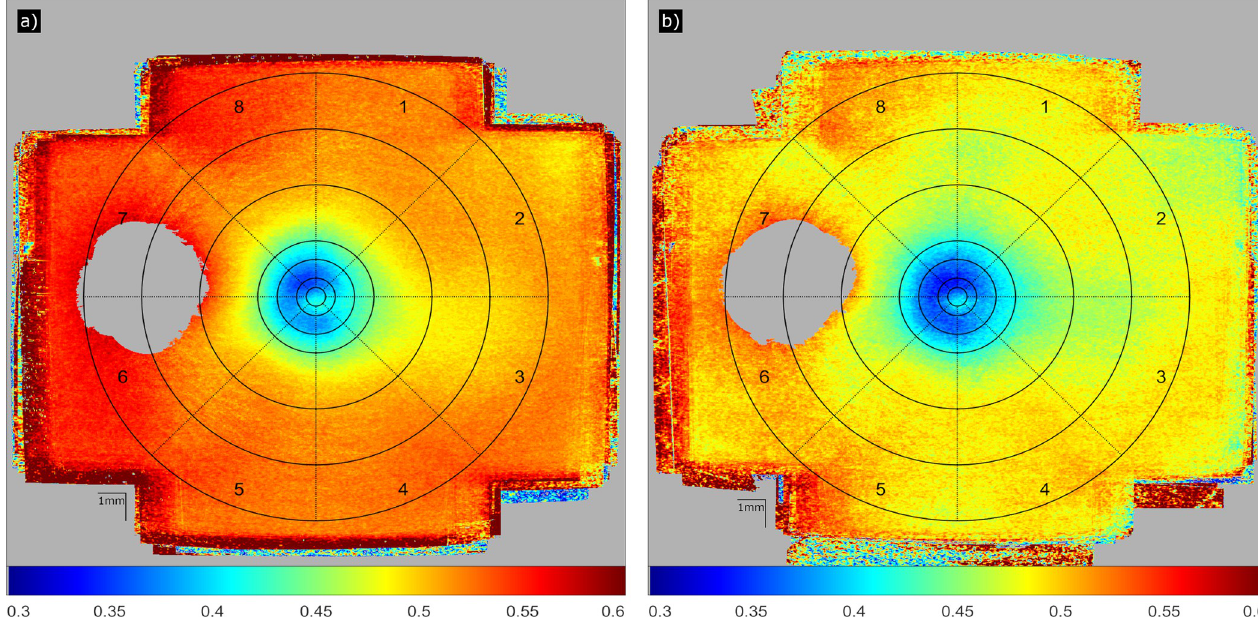
Fig 2. Depolarization caused by the RPE visualized by DOPU, averaged over 105 healthy volunteers (a) and 48 glaucoma patients (b), respectively. The grids are centered at the fovea and the diameter of the innermost circle (A) is 0.5 mm. The outer diameters of the surrounding rings (center to periphery: B, C, D, E, F, and G) are 1, 2, 3, 6, 9, and 12 mm, respectively. The sectors are numbered from 1 to 8. The color scheme corresponds to DOPU (low DOPU value [blue color] indicates strong depolarization), with gray indicating locations that have been excluded from the